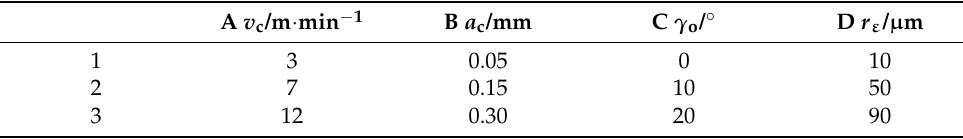
Table 1. Factors and levels of orthogonal